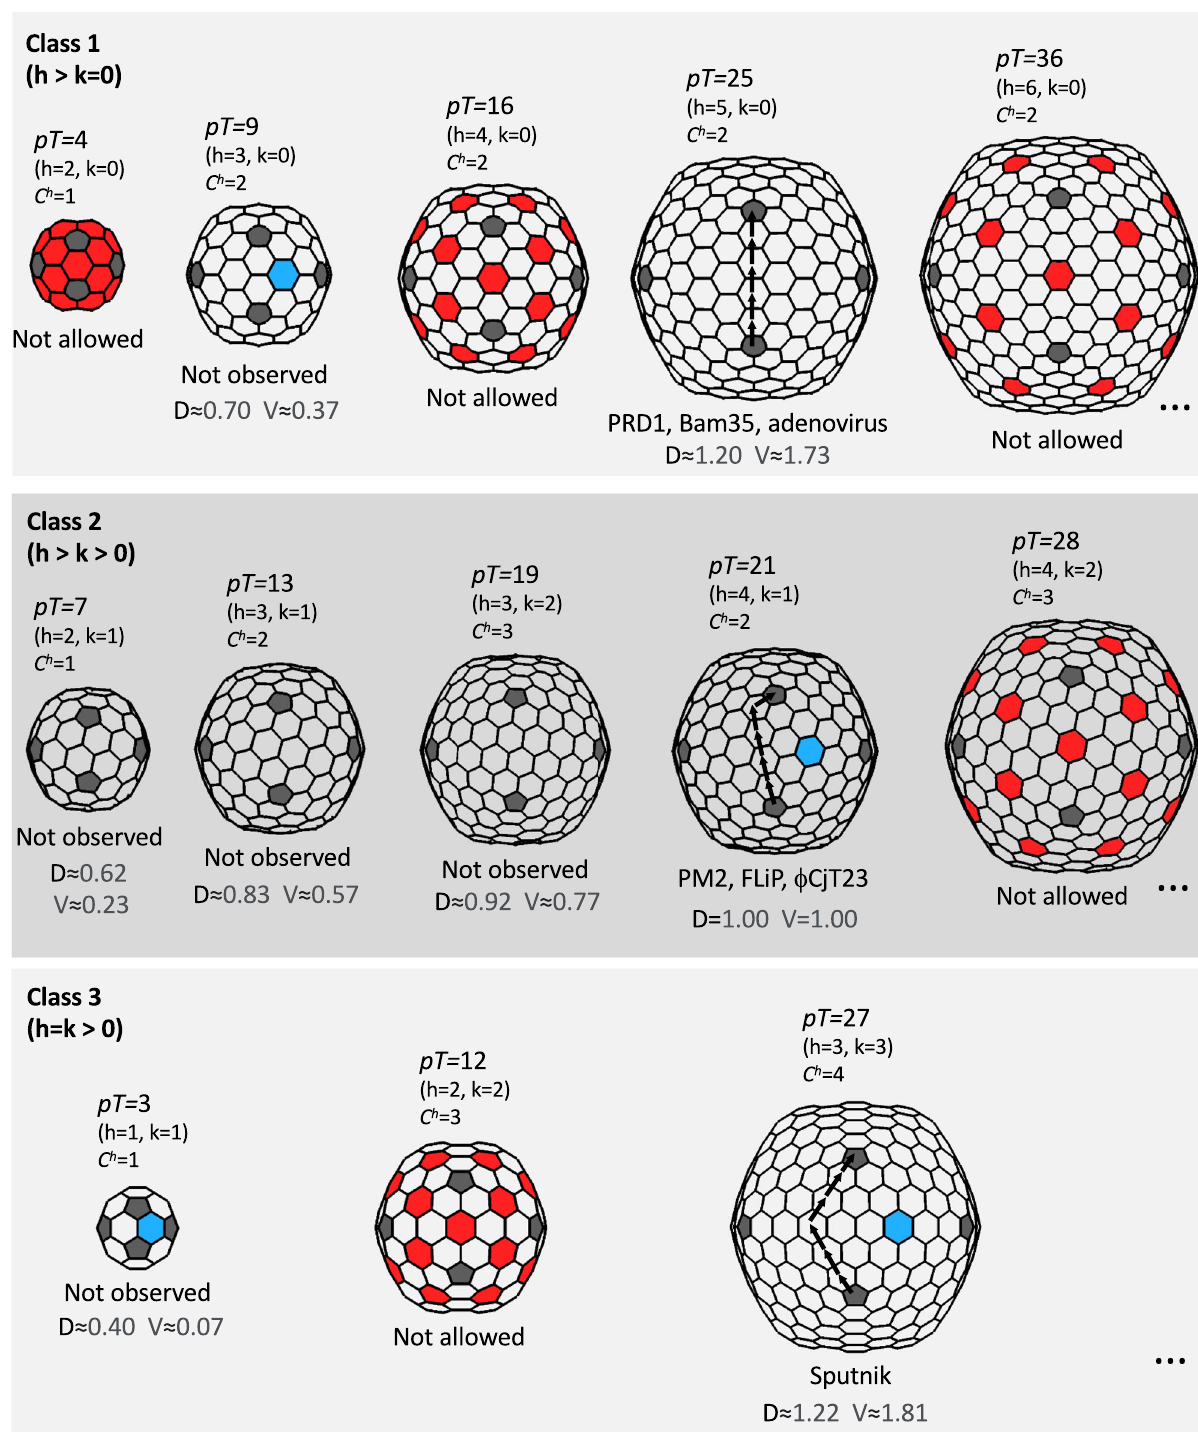
Fig. 6 | Icosahedralvirus capsid architectures. A schematicdiagram isshown for differenttypesoficosahedrallysymmetriccapsidsbuiltof 12pentagons(gray)and N =60×( T – 1)/6 hexagons (white). The triangulation ( T ) number of each capsid is de fi ned by two lattice indexes h and k as T = h 2 + h × k + k 2 . In the members of the PRD1 – adenovirus lineage ( Bamfordvirae ), the allowed hexagon positions are occupied by pseudohexameric trimers, hence the T -number is indicated being pseudo ( p ). Different capsid types are classi fi ed in classes 1, 2, and 3 (ref. 32). Only the fi rst members of the series ( … ) are shown in each class. The lattice axes are illustrated for one capsid in each class with arrows. Hexagons that are located on the icosahedral two-fold axes of symmetry, and that thus cannot be occupied by a